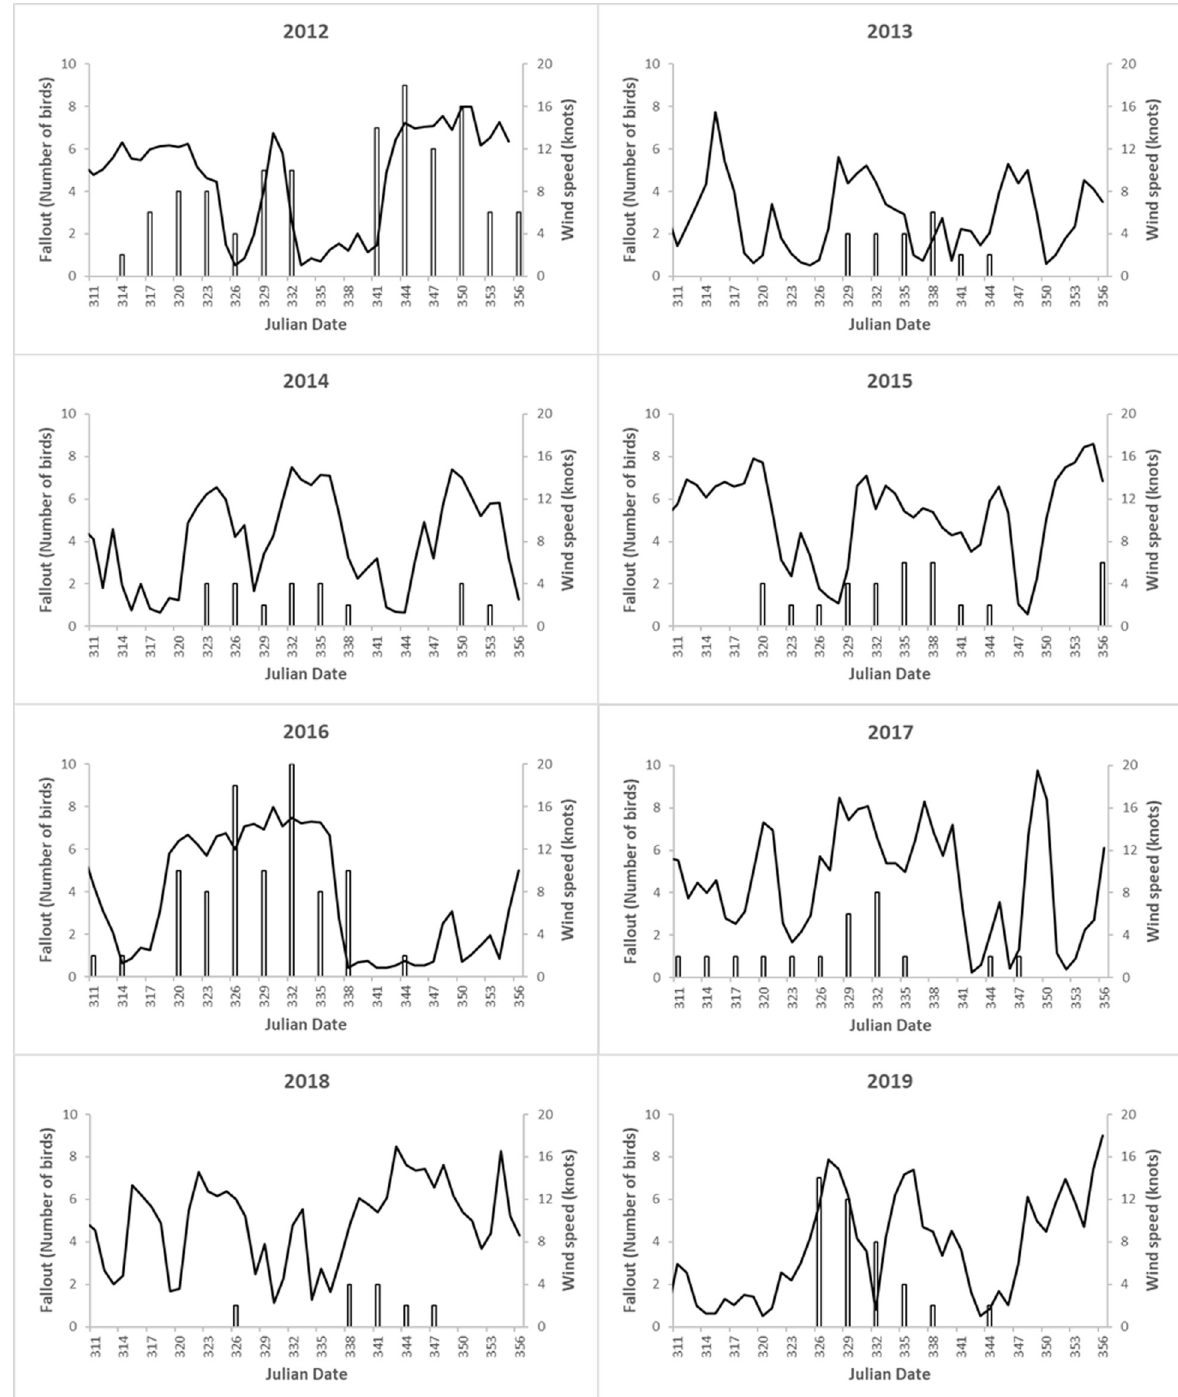
Fig 6. Wind speed and fallout. Time series of the number of grounded WTSH observed per survey (bars) and nightly wind speed (back line). The dates on the x-axis indicate the survey days.